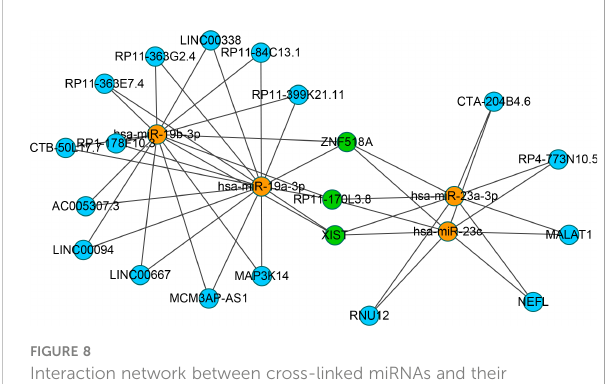
FIGURE 8 Interaction network between cross-linked miRNAs and their targeted LncRNAs. The miRNAs are represented as organge, the LncRNAs are represented as blue, and the cross-linked LncRNAs are represented as green.